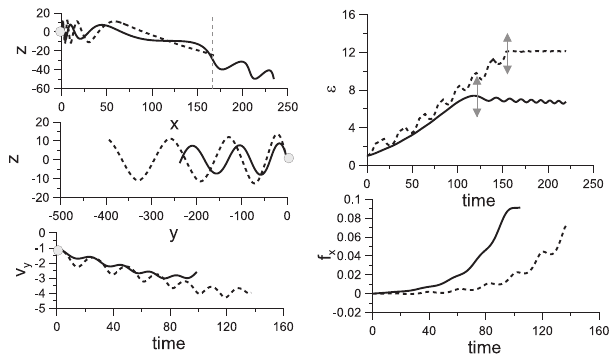
Fig. 3. Profiles of potential energy U(b n x 0 ,z) = 1 for two values of b n x 0